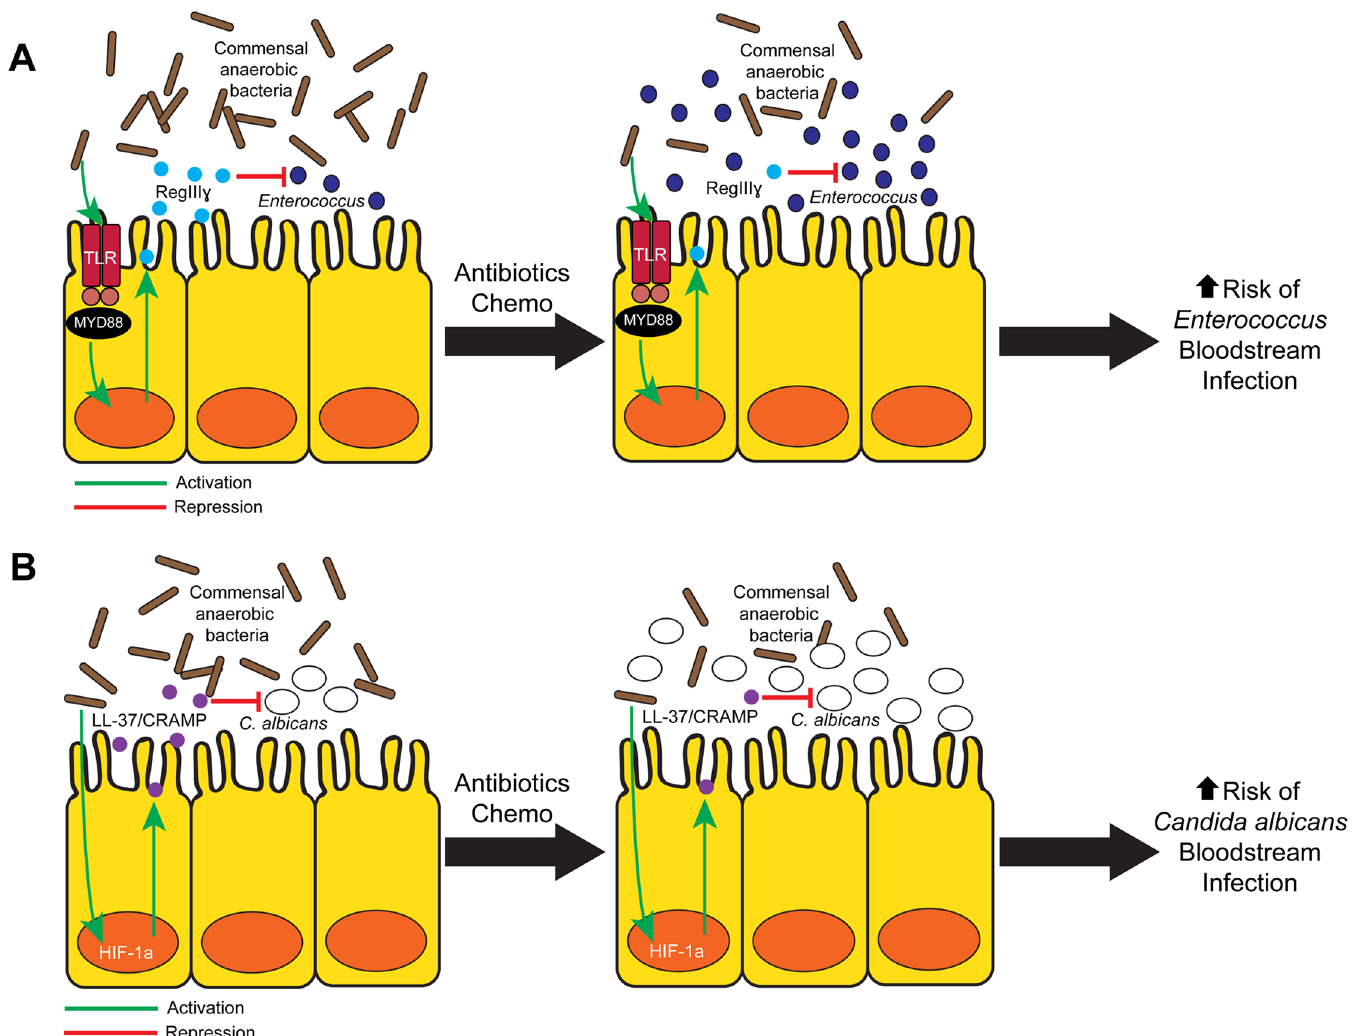
Fig 1. Overviewof commensal gut microbiota modulation of colonization resistance to pathogenic bacteria and fungi. (A) Commensal gut microbiotainducesthe intestinalantimicrobial peptideregenerating islet-derivedprotein 3 gamma (RegIII γ ), which has activity againstgram-positive bacteria, including Enterococcus , via a TLR/MyD88-dependent mechanism [14]. Antibiotic therapy can depletecommensal gut microbiota, thereby resulting in decreased levels of RegIII γ and a concomitantincreasein Enterococcus colonization [17]. Increasedgut Enterococcus burdenis associatedwith a significantly increasedrisk of Enterococcus bloodstreaminfectionsin stem cell transplant patients [2]. (B) Commensal gut microbiota(particularly the Bacteroidetes and ClostridialFirmicutes) induceintestinalproductionof the transcription factor hypoxia-inducible factor-1 α (HIF-1 α ), which in turn regulates production of the antimicrobial peptideLL-37/CRAMP, which has activity against Candidaalbicans [15]. Antibiotic-induceddepletionof commensal anaerobic bacteria results in decreased intestinal HIF-1 α and LL-37/CRAMP levels and results in increased C . albicans dissemination in mice [15]. TLR, toll- like receptor; MyD88, myeloiddifferentiationprimary response gene 88.